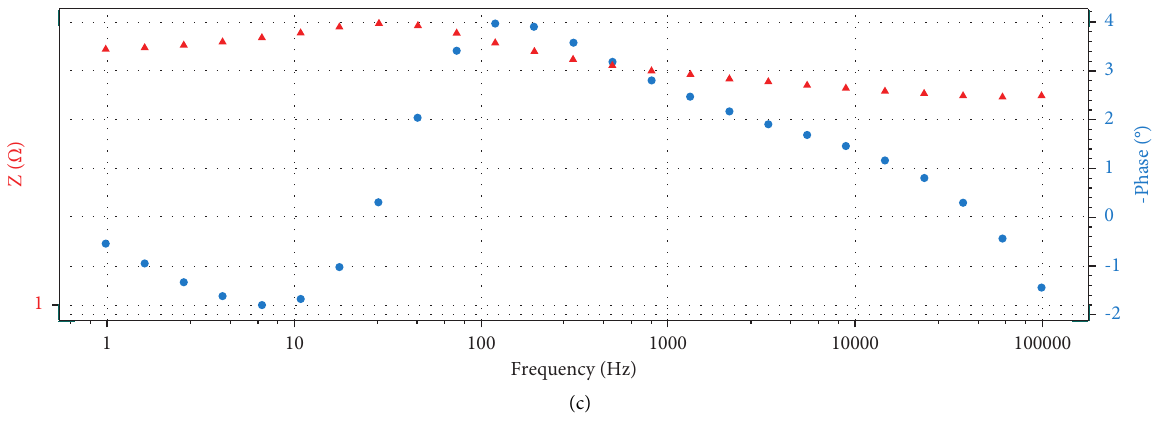
Figure 8: Phase angle plots of uncoated GrA1, interface, and WC-flyash-coated GrA1